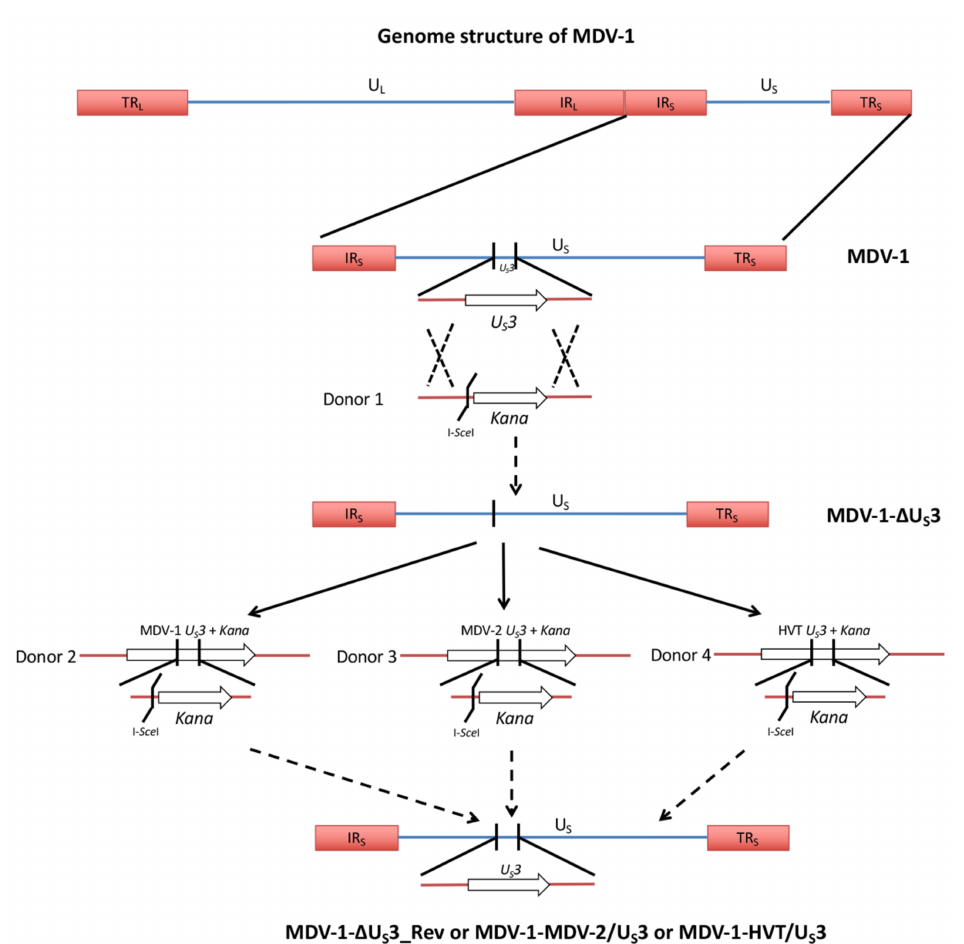
Figure 1. Construction of U S 3 deletion, revertant and chimeric MDVs. MDV-1 genome consists of unique long and short regions (U L , U S ) and inverted repeat long and short regions (TR L , IR L , TR S , IR S ). U S 3 was deleted from a bacterial artificial chromosome (BAC) containing the genome MDV-1, strain 686, using a two-step Red-mediated recombination method (MDV-1- ∆ U S 3 BAC). The U S 3 deletion BAC was used as a backbone to construct MDV-1- ∆ U S 3_Rev (revertant), MDV-1-MDV-2/U S 3 (chimeric MDV-1 expressing MDV-2 U S 3), and MDV-1-HVT/U S 3 (chimeric MDV-1 expressing HVT U S 3) BACs. All BACs were transfected into chicken embryonic fibroblasts (CEF) to produce recombinant viruses. Table 1. Lymphoid organs to body weight ratio of inoculated and negative control chickens on day 14 post-inoculation.